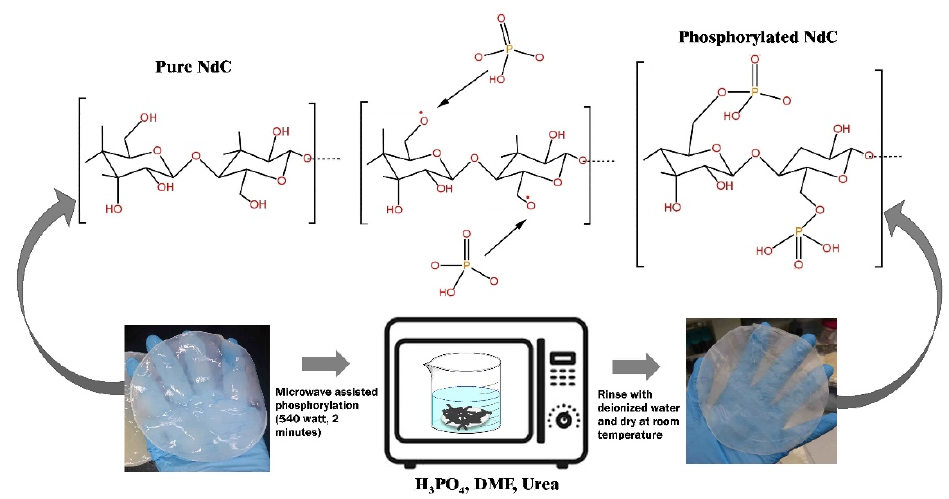
Figure 1. Phosphorylation process of Nata de Cassava.